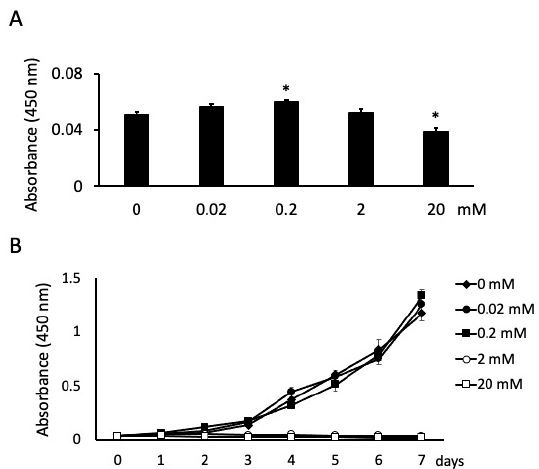
Figure 1. Effects of butyric acid (BA) on cell proliferation. Cells were incubated with several concentrations of sodium butyrate (NaB). Cell proliferations were measured at 24 h ( A ) and every 24 h until 7 days ( B ). Values are the mean ± standard deviation from eight independent experiments. * Significantly different from control cells (0 mM) ( p < 0.05).